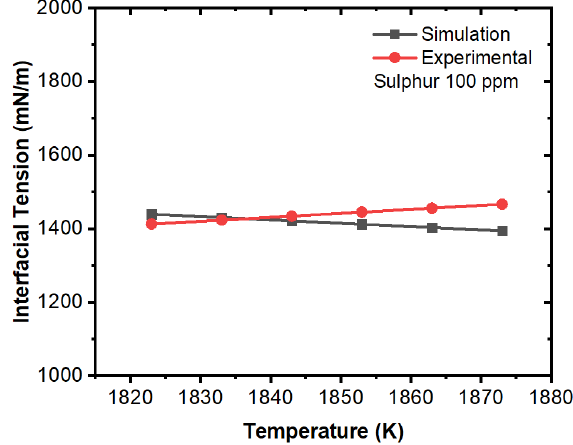
Figure 17. Comparison of experimental and simulation results of interfacial tension with respect to temperature (sulfur: 70 ppm, experimental work by Jeong et al. [26]).